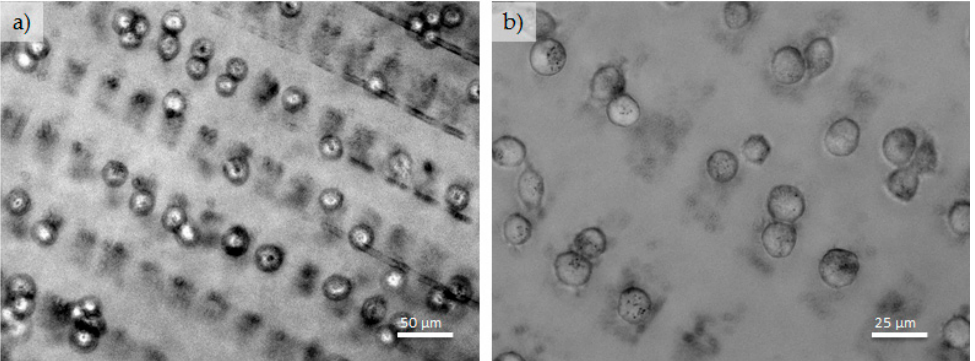
Figure 8. ( a , b ) Optical images of fibroblast adhesion on an Au NPs (120 nm) patterned PEG-hydrogel exhibiting rectangular patterns of Au NPs.